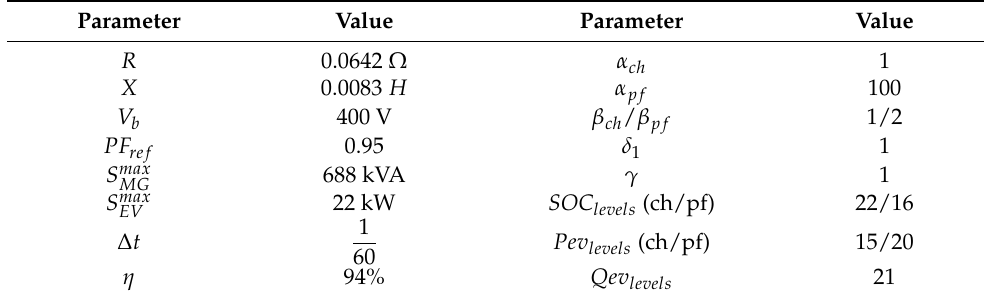
Table 3. Microgrid and control parameters.